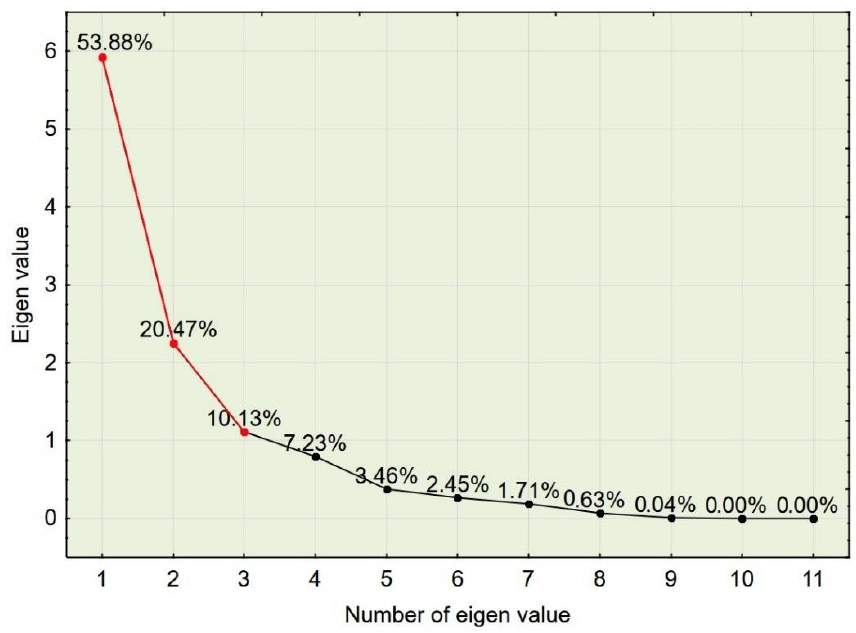
Figure 4. Scree plot of eigenvalues.